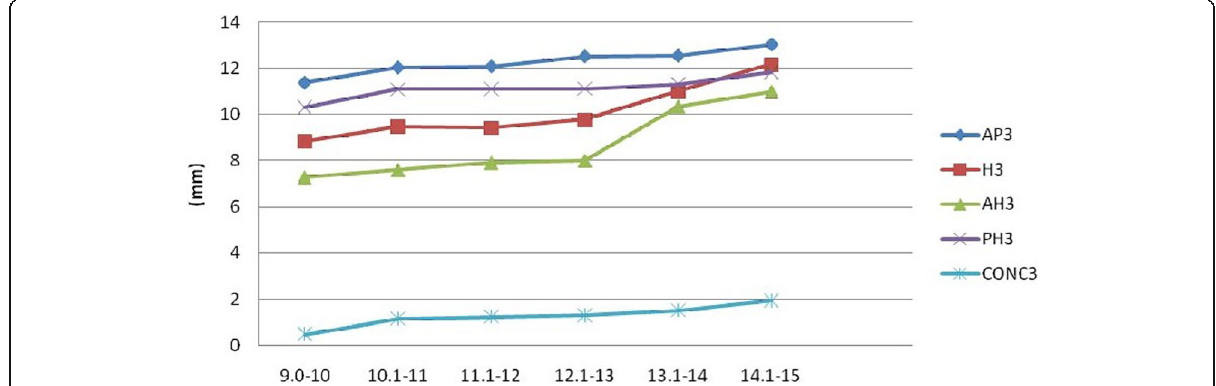
Fig. 4 Changes in the parameters of C3 in males (AH, anterior height; PH, posterior height; H, middle height; AP, anteroposterior length; CONC, depth of concavity)